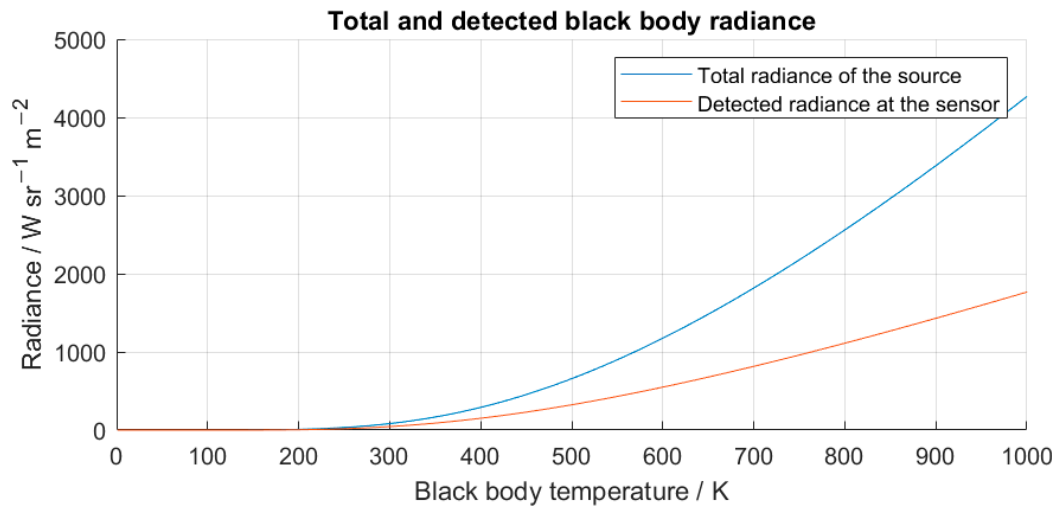
Figure 6. The total radiance of a black body source at different temperatures and the actual detected radiance at the sensor, forming the sensor characteristic function. VOx sensor sensitivity from Figure 5 was used for this plot.